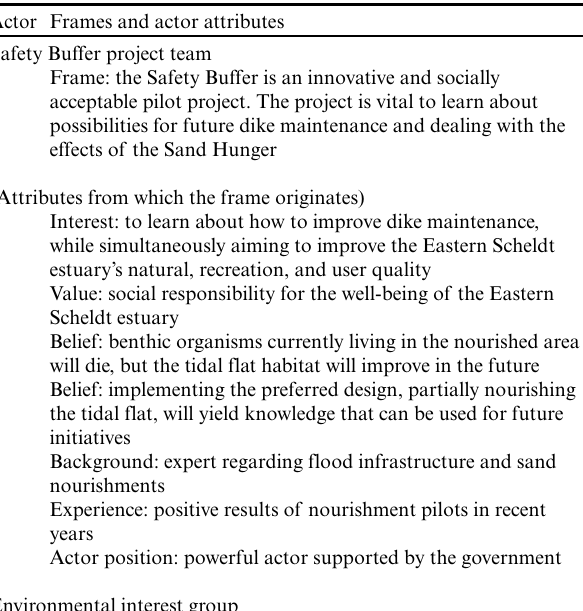
Table 6 . Safety Buffer Oyster Dam ambiguity 2: about the acceptability (benthic